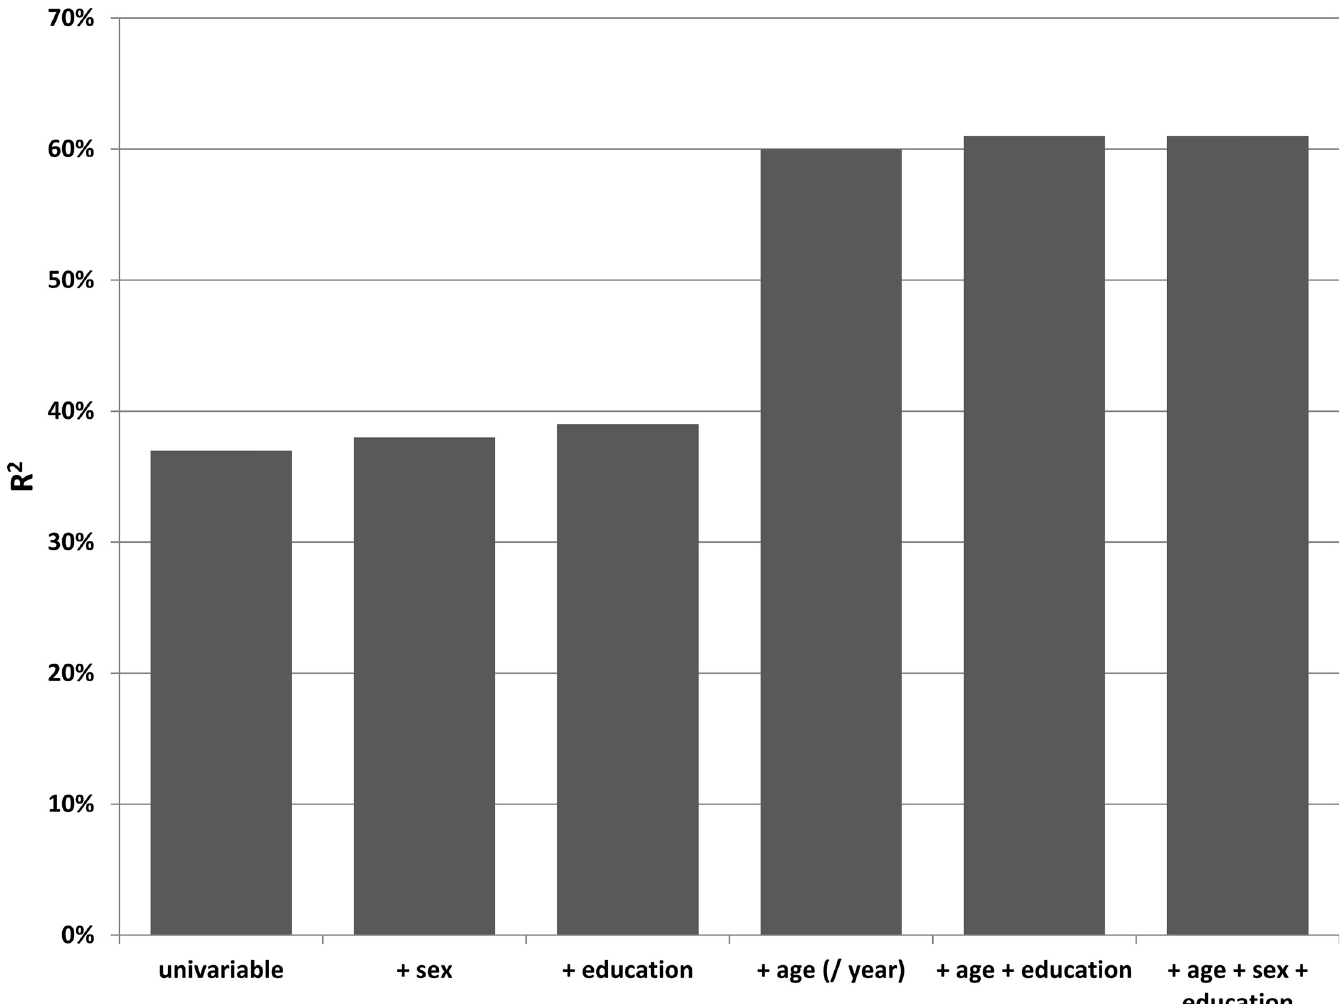
Fig 2. Results from the linear regression analysis for the question: ‘Do you have any difficulty with your hearing?’. First univariable analysis was done, then each of the independent covariates were added, initially separately and later together. R 2 is given as a measure of the goodness of fit of the model.